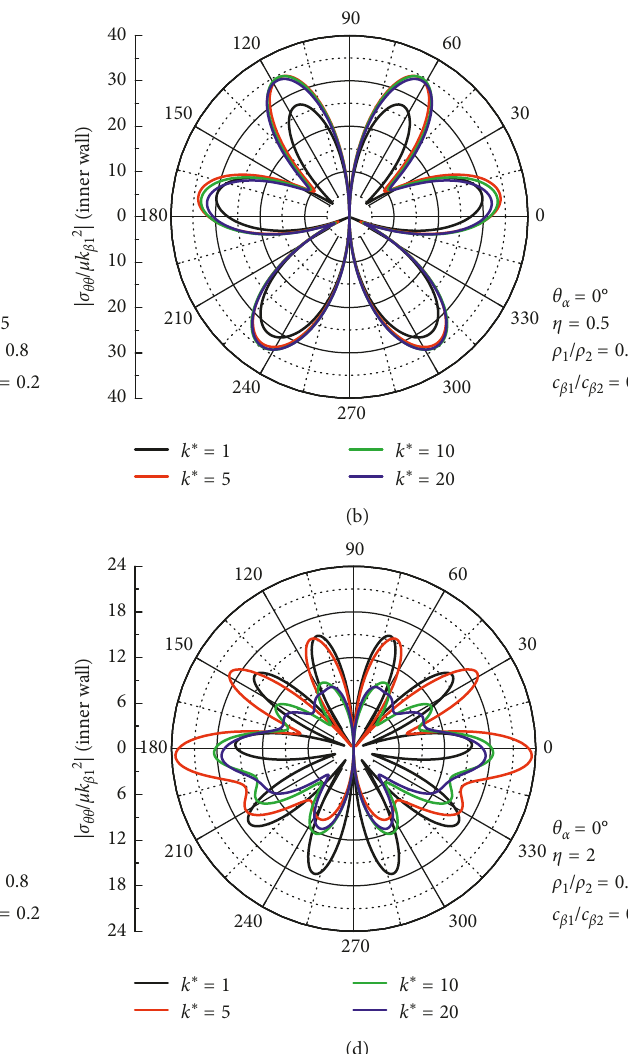
° ): (a) η 0 . 25; (b) η 0 . 5; (c) η 1; (d) η α (cid:29) 0 (cid:29) (cid:29) (cid:29) (cid:29)